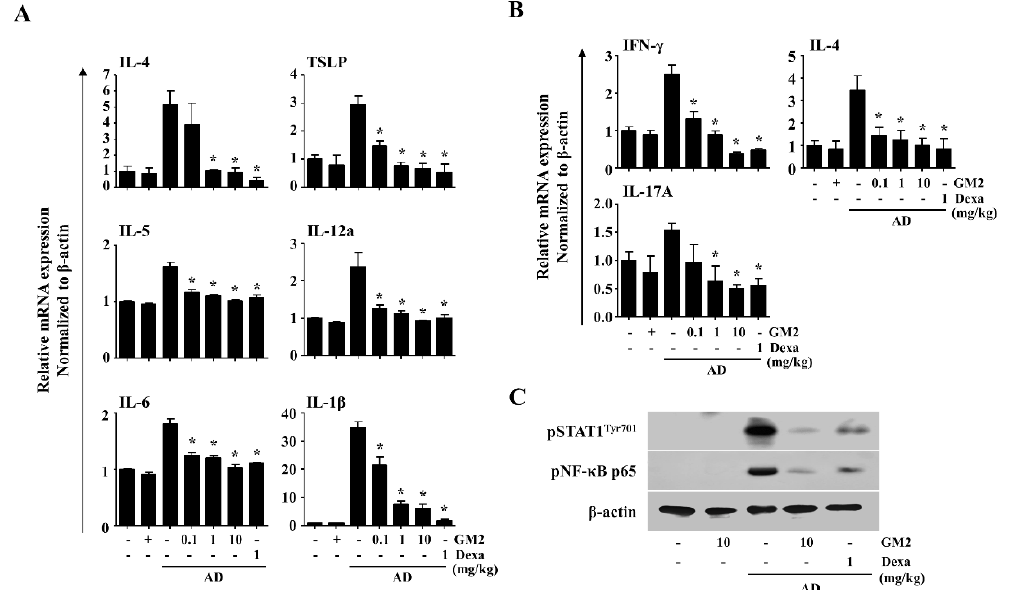
Figure 4. Effects of GM2 on the inflammatory mediator response in AD mice. ( A ) qPCR was used for the measurement of AD-related cytokines in AD-like skin lesions. ( B ) AD-related cytokines were measured by qPCR in the auricular lymph node of AD mice. Data presented in the graph represents the means ± SEM ( n = 5). * p < 0.05, compared with the DNCB/DFE-induced group. ( C ) The activation of STAT1 and NF- κB phosphorylation were analyzed by Western blot in AD-like skin lesions. β -actin was used as a loading control and blots used independent blots from randomly selected three of ear tissues per each group. Dexa: dexamethasone.